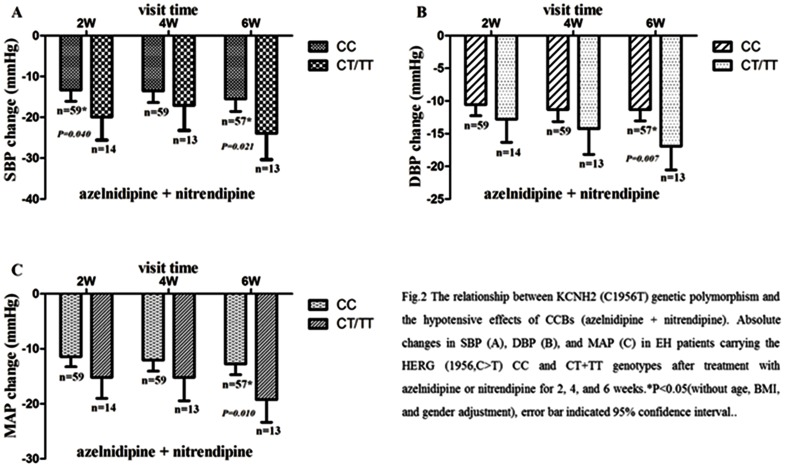
The relationship between KCNH2 (C1956T) genetic polymorphism and the hypotensive effects of CCBs (azelnidipine & nitrendipine).Absolute changes in SBP (A), DBP (B), and MAP (C) in EH patients carrying the KCNH2 (1956,C>T) CC and CT+TT genotypes after treatment with azelnidipine or nitrendipine for 2, 4, and 6 weeks.*P<0.05(without age, BMI, and gender adjustment), error bar indicated 95% confidence interval.